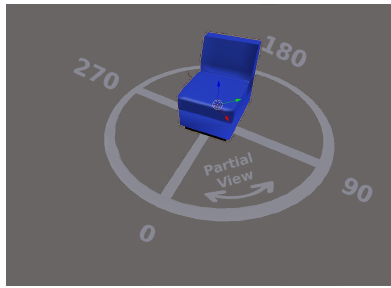
Figure 11. Visualizing the different points of view used to generate partial